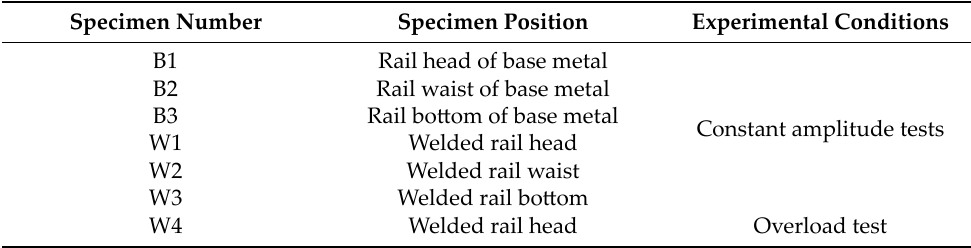
Figure 1. ( a ) Schematic diagram of specimen sampling; ( b ) dimensional diagram of unloaded specimen; ( c ) dimensional diagram of overloaded specimen. Table 1. Specimen number and experimental conditions.